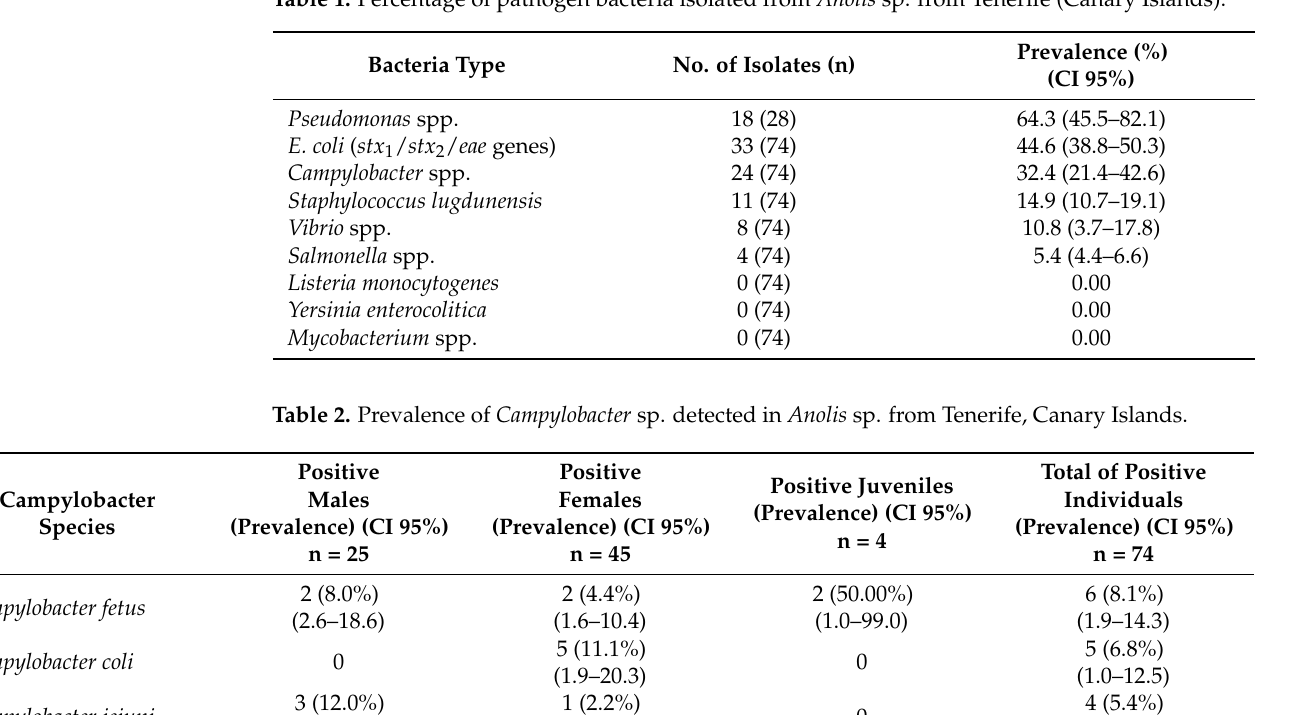
Table 1. Percentage of pathogen bacteria isolated from Anolis sp. from Tenerife (Canary Islands).